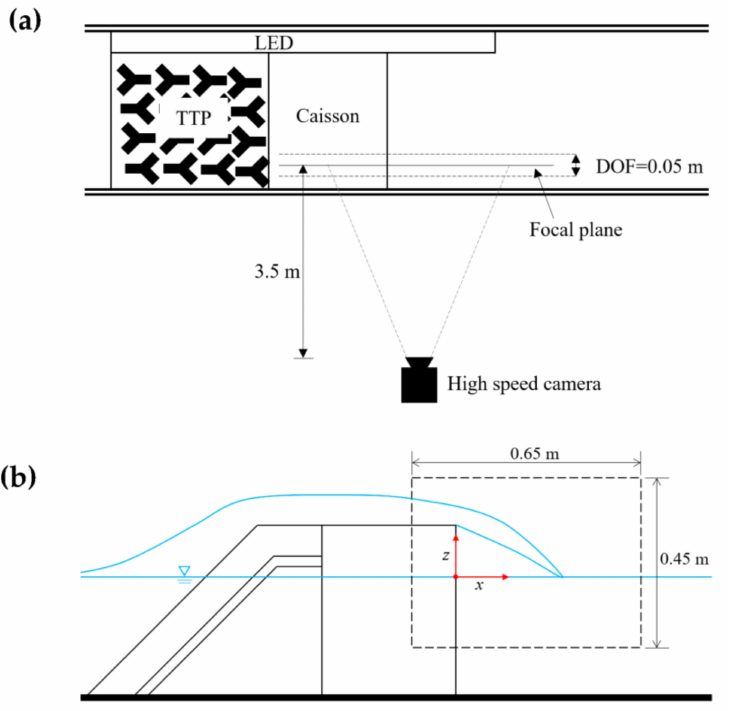
Figure 4. Scheme of the BIV setup: ( a ) Camera position and ( b ) the field of view